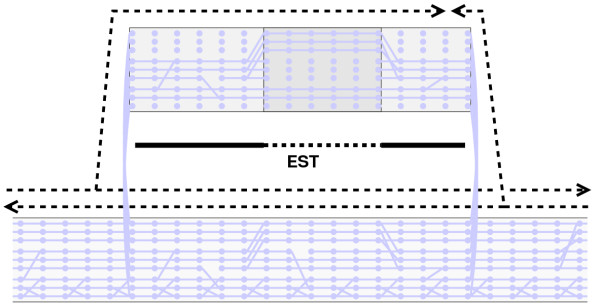
Extension of EuGène's graph by a PCS to incorporate a single alternative transcript alignment. From the main graph (bottom) described in Figure 3, a Parallel Graph Subunit (PGS) is built (above) by duplicating the whole graph section involved in the EST alignment (between the graphs). Gene structure evidences provided by the alignment are taken into account in the PGS by forbidding the intergenic track all along the alignment, intronic tracks at match positions (light grey), and exonic tracks in gap positions (dark grey). Dotted arrows represent the two algorithm scans, the forward version from left to right, and the backward version from right to left. At the junction point in the PGS, an optimal prediction is obtained. Figure not to scale.